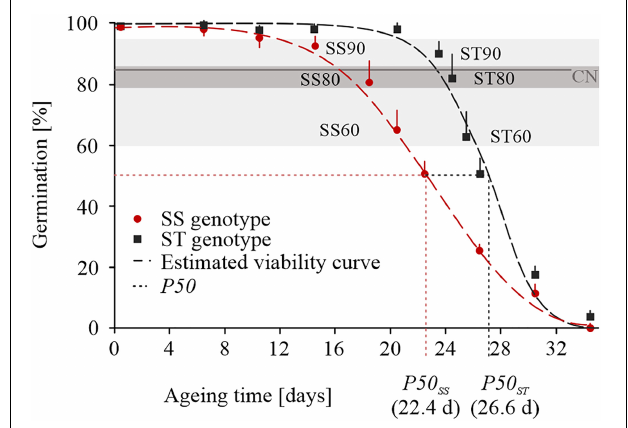
FIGURE 1 | Seed viability curves and P50 of the storage-tolerant (ST) wheat accession TRI 23248 and the storage-sensitive (SS) accession TRI 10230 following artificial aging treatment. Mean and standard error of three replicates is given. ST90, ST80, ST60, SS90, SS80, and SS60 represent stages (PI, PII, PIII) around and close to the critical node (CN) of seed germination (85%) that were used to proteomic analysis. The half-viability period (P50) is given for ST and SS seeds. Color code provided in the